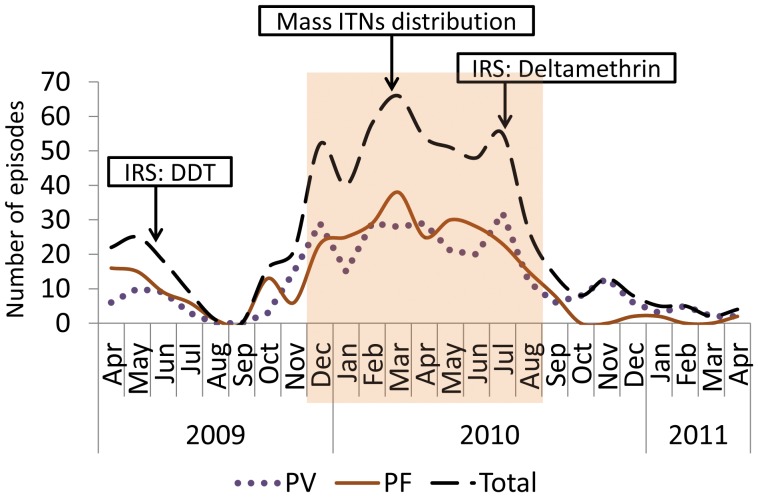
Monthly malaria incidence, time of interventions and time span of the most likely spatio–temporal cluster of all types of malaria.The shaded part indicates the time-span of the most likely space–time cluster.